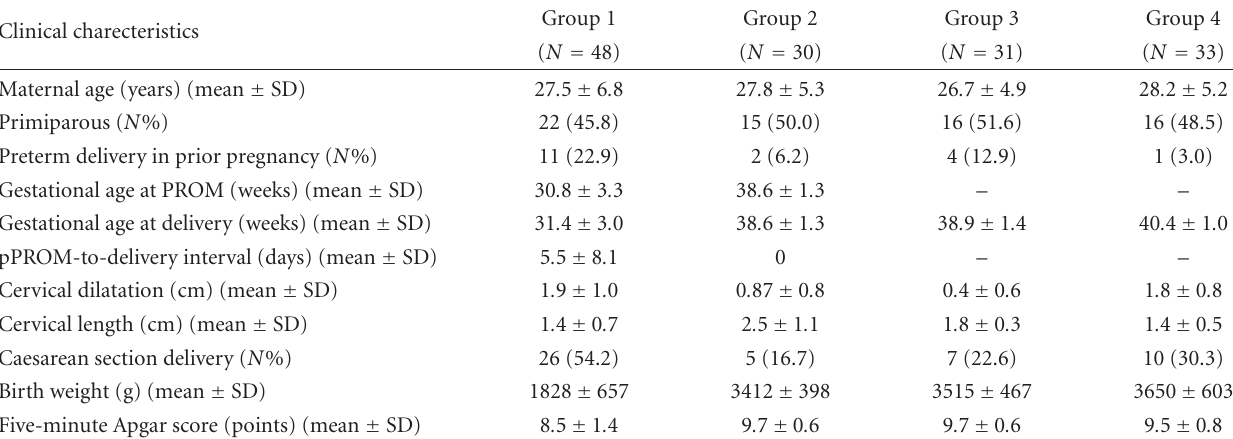
Table 1: Clinical characteristics of the groups.